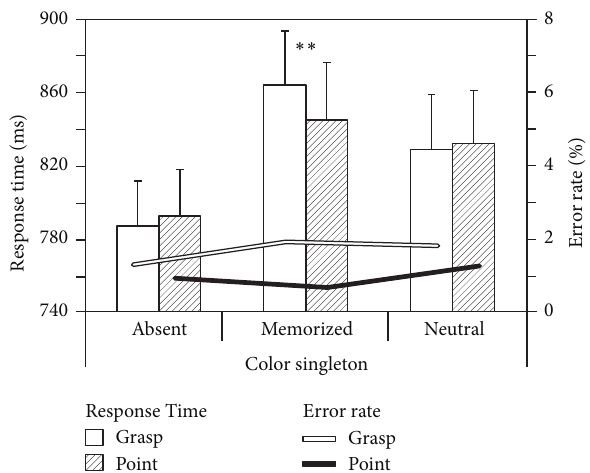
Figure 2: Response times (left 𝑦 -axis) and error rates (right 𝑦 - axis). White bars and lines represent performance in trials in which participants planned a grasping movement. Shaded bars and black lines represent performance in trials in which participants planned a pointing movement. Asterisks ( ∗∗ ) indicate a 𝑝 value ≤ 0.01 for a direct comparison of grasp and point. Error bars represent standard errors of the mean.